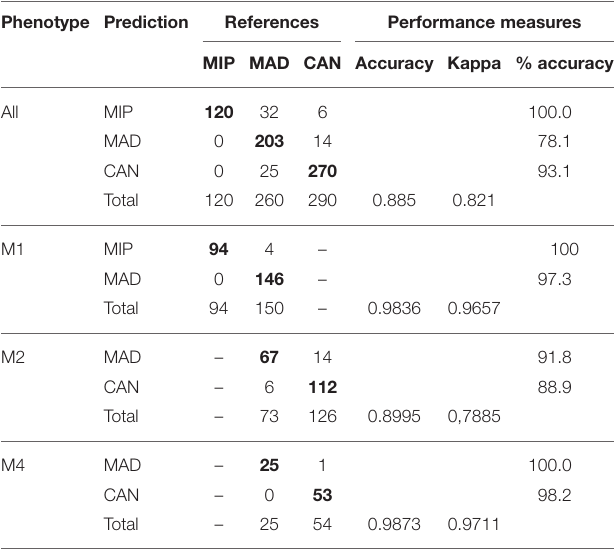
TABLE 2 | Phenotype abundances of Trachurus picturatus sampled off the north and central eastern Atlantic